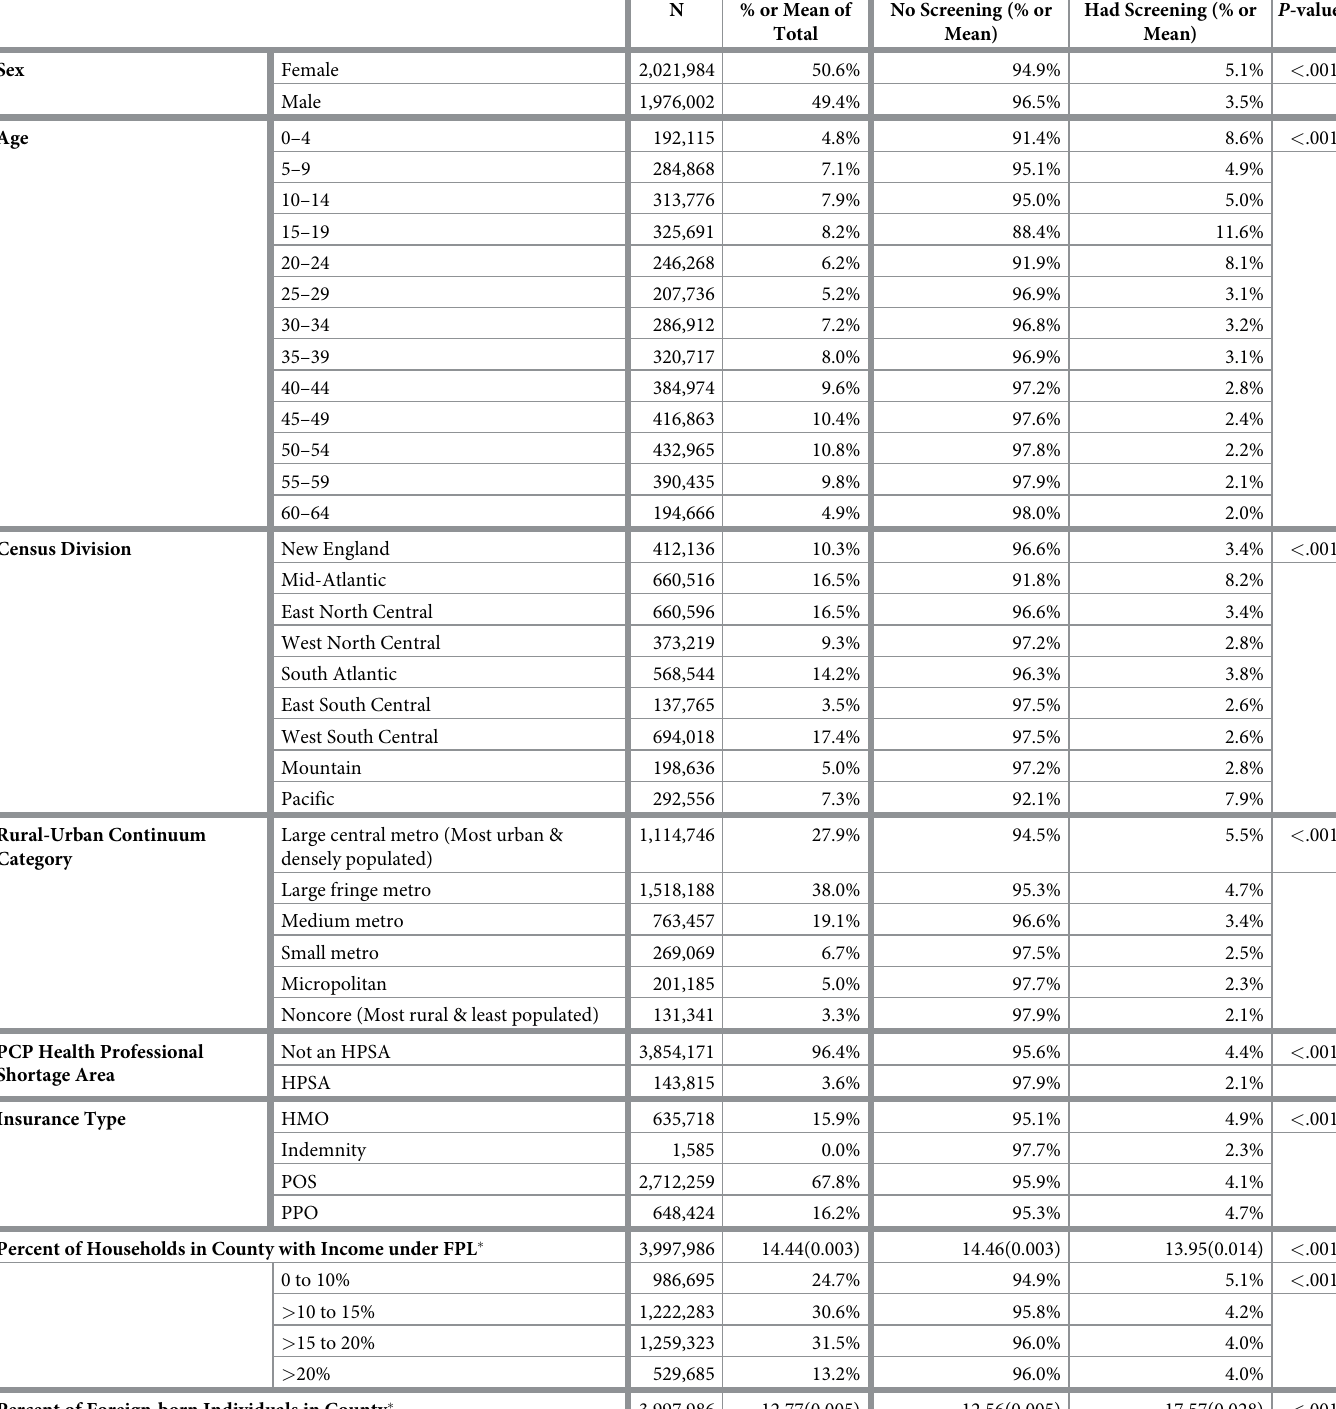
Table 2. Frequency distributions of variables describing commercially insured individuals ages 0 to 64 years and the proportion of people with these characteristics who were screened for Mycobacterium tuberculosis with a tuberculin skin test (TST) or an interferon-gamma release assay (IGRA) between 2011 and 2013, based